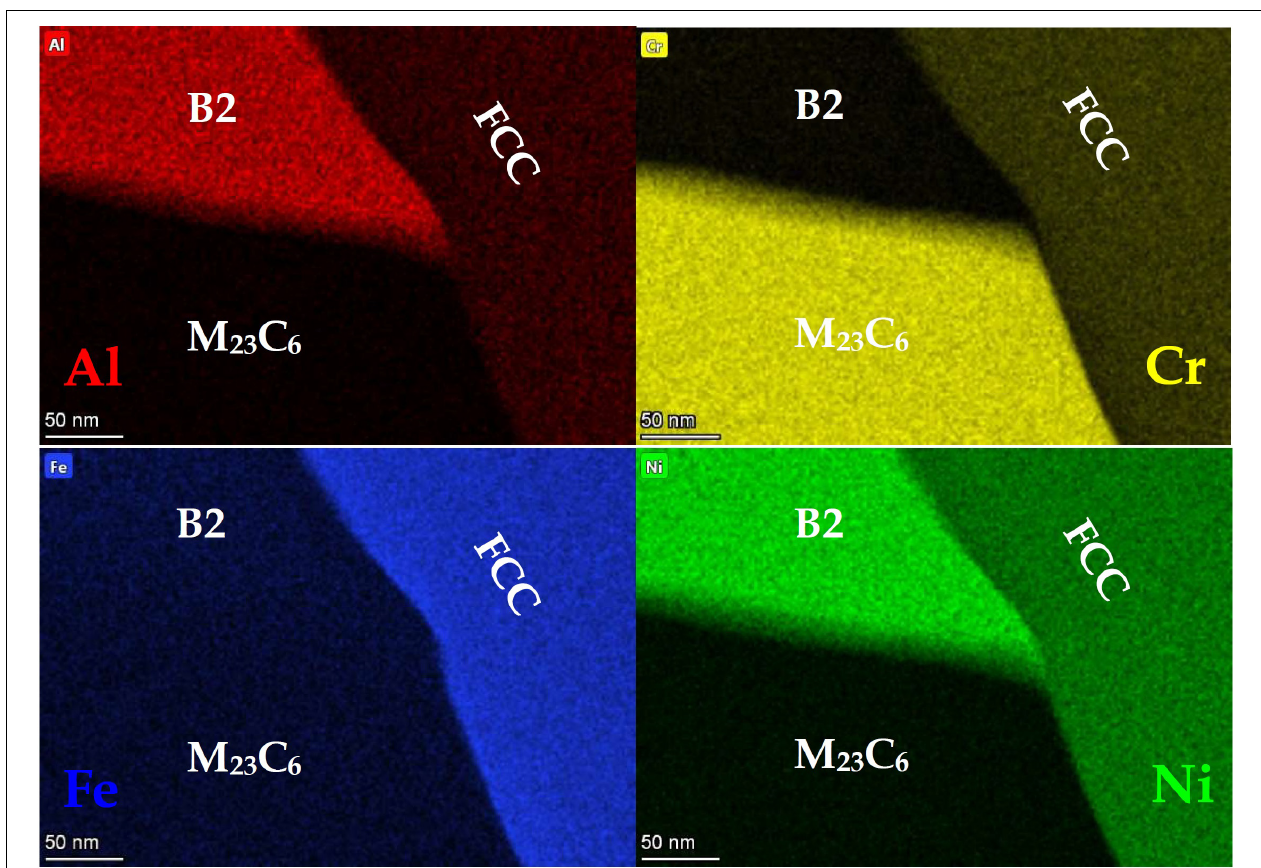
FIGURE 8 | High Resolution S/TEM EDS map (STEM mode) of the area marked in Figure 6 in the homogenized AlCrFe 2 Ni 2 alloy.